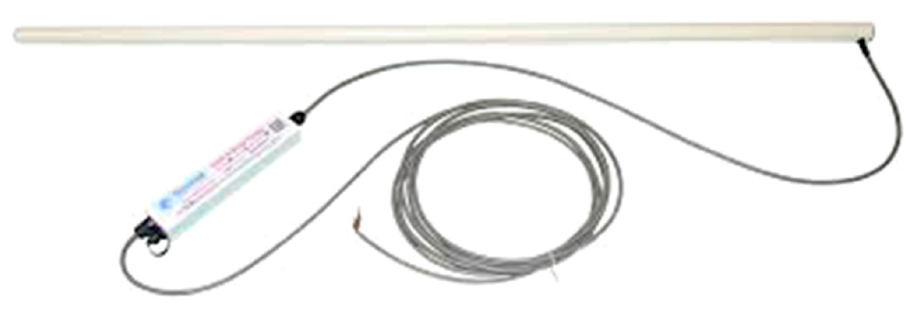
Figure 5. The Drill&Drop probe.